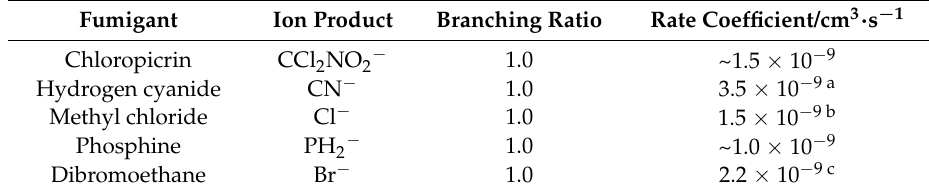
Table 2. OH − reactions of fumigants in nitrogen carrier gas and flow tube at 120 °C.